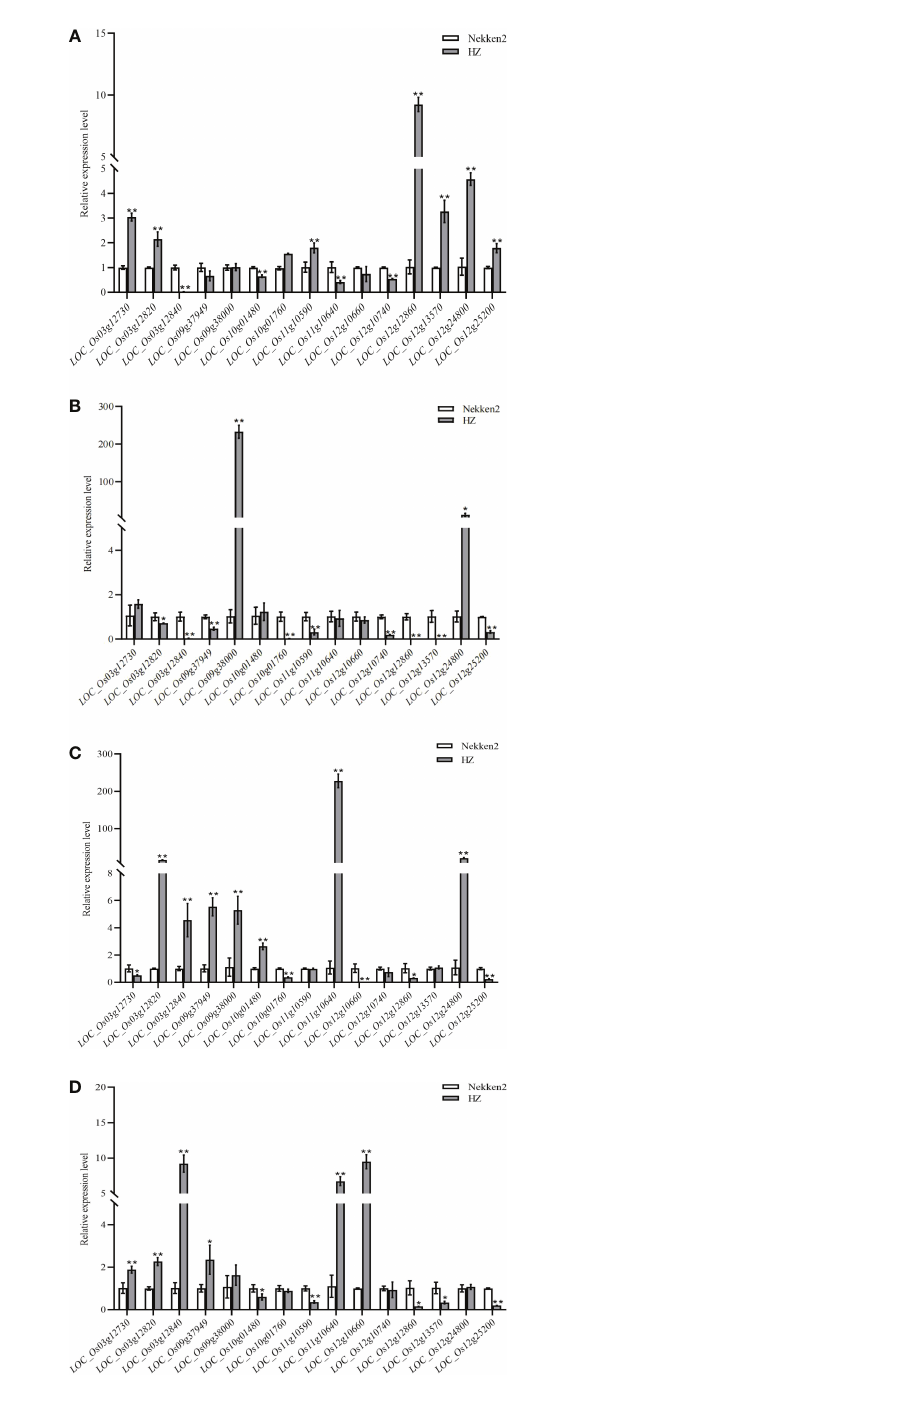
indicator for QTL detection. Based on the results of QTL interval localization, we combined with qRT-PCR and mapping of substitution lines, we explored and analyzed possible genes involved in regulating salt stress tolerance in rice to provide a theoretical basis for expanding the use of land with high soil salinity and improving the yield and quality of rice under this condition.